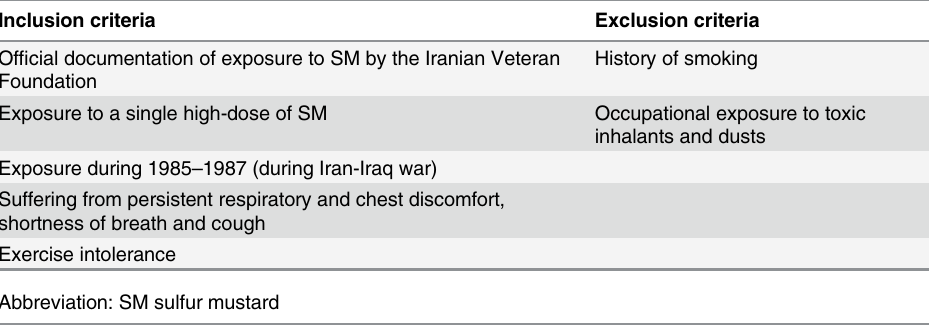
Table 2. Patients inclusion and exclusion